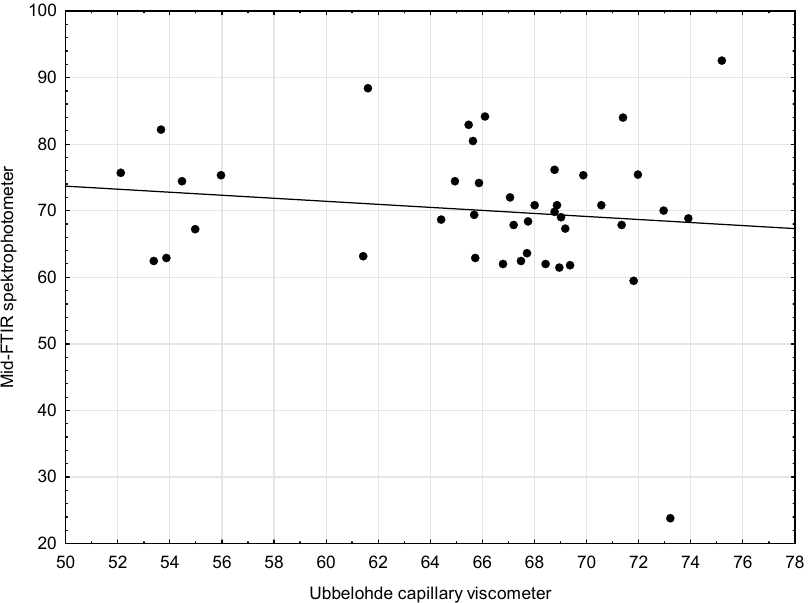
Figure 3. Scatter plots with regression lines for the kinematic viscosity—Capillary viscometer and Mid-FTIR spectrophotometer.